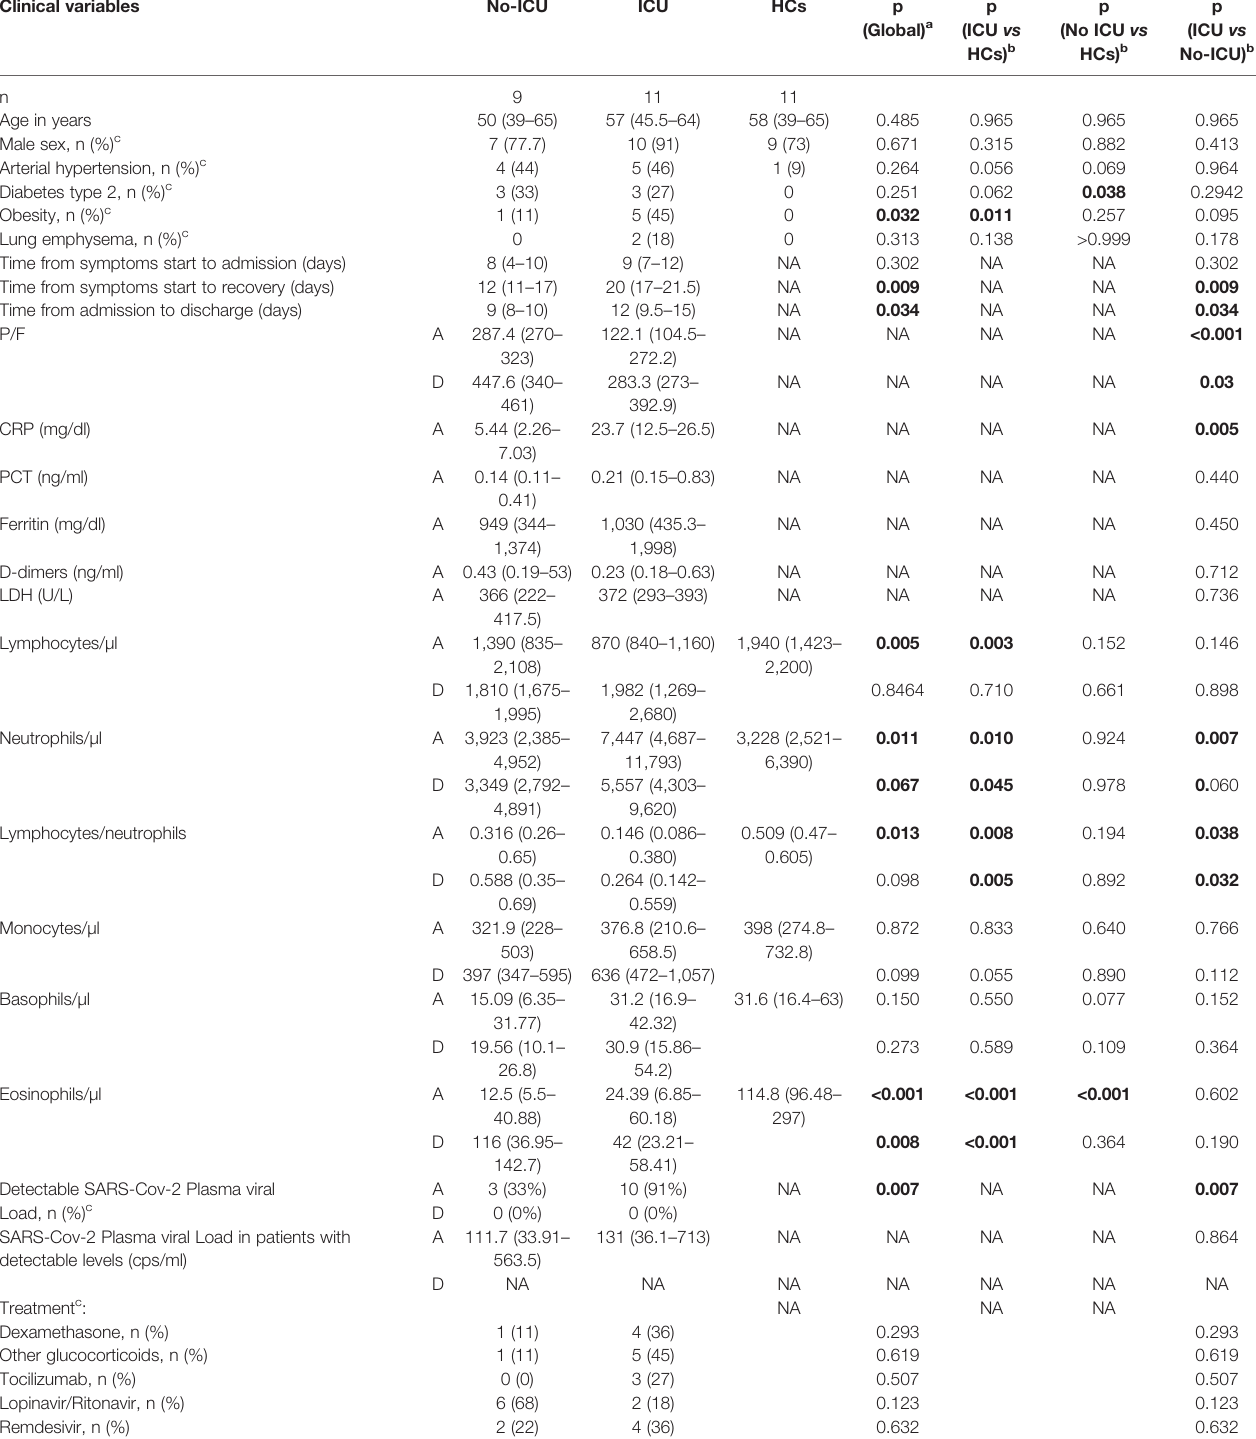
TABLE 1 | Clinical and routine laboratory data from patients and healthy controls. Clinical